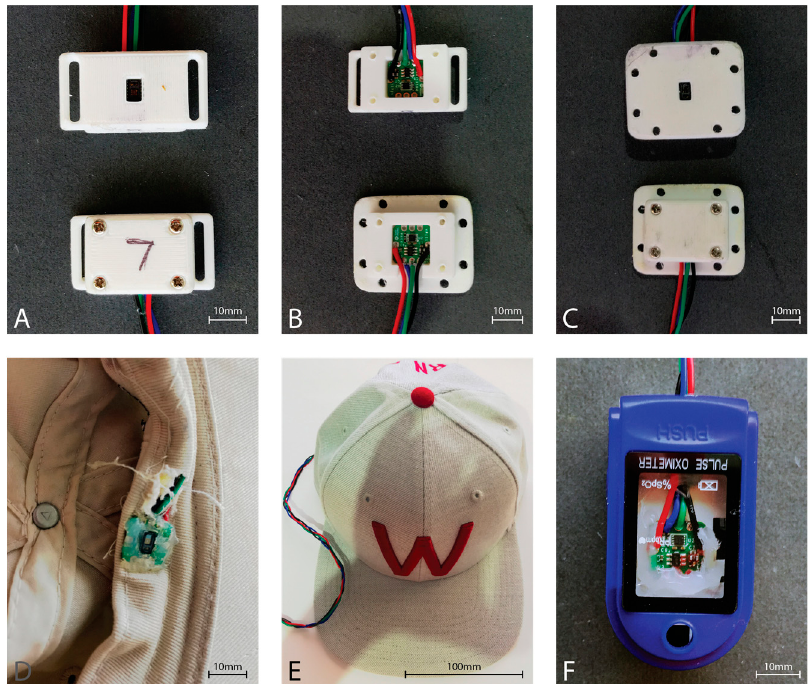
Figure 3. MAX30102 PPG sensor housings. ( A ) Strap type sensor housing used with a Velcro strip for attachment to a sports brace to the tibia. Top showing the skin-side, and bottom showing the outer housing. ( B ) Top shows the mounting of the sensor in the strap housing, while the bottom shows the sensor mounted in the housing used with sports tape. ( C ) Housing used with sports tape for sticking to the skin. Top showing the skin-side of the sensor housing, while the bottom shows the outer sensor housing. ( D ) Inside front brim of the hat showing the sensor board integrated into the brim. Note the neutral cure silicon protecting the sensor from perspiration during use. Wiring is fed behind the brim and exits behind the head. ( E ) The outside view of the hat with the sensor wire extending from the rear opening of the hat. ( F ) Modified commercial fingertip pulse oximeter housing. The hardware for the commercial pulse oximeter was removed from the housing, and the MAX30102 sensor board was a ffi xed with neutral cure silicone such that the sensor window exited through the hole originally utilized by the commercial